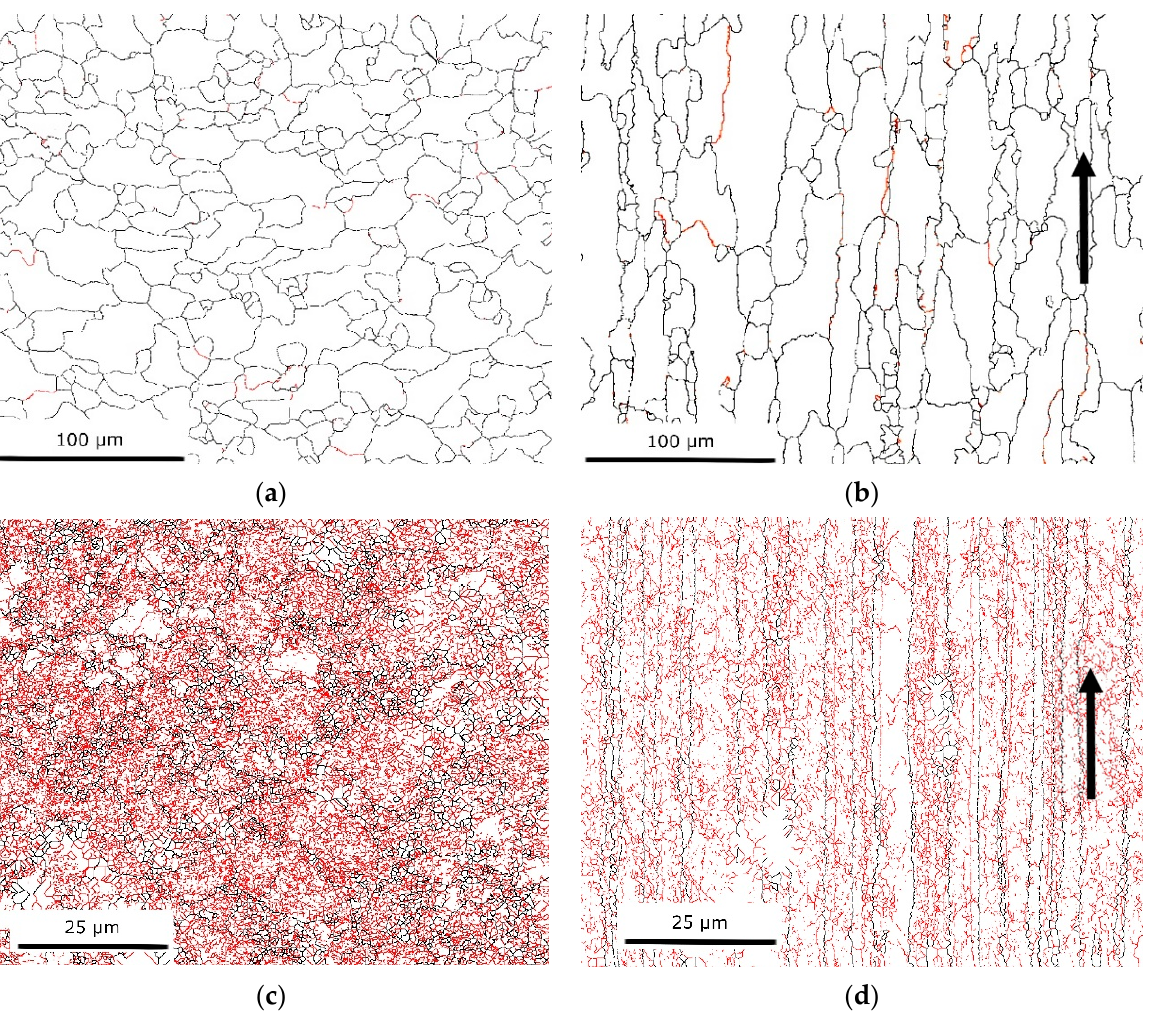
Figure 1. Grain boundary maps, with LAGBs shown in red, and HAGBs shown in black: ( a ) CG transverse plane, ( b ) CG longitudinal plane, ( c ) HE transverse plane, and ( d ) HE longitudinal plane; black arrows indicate the direction of the hydrostatic extrusion.